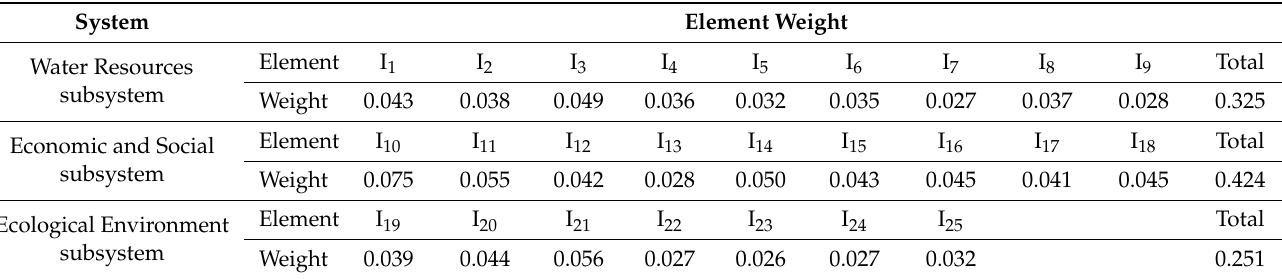
Table 3. Water resources subsystem element